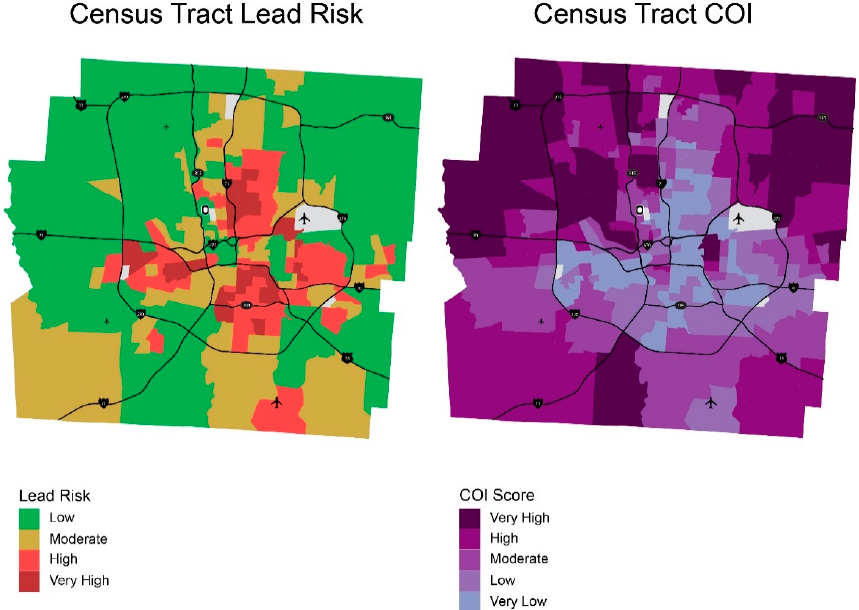
Figure 8. Lead risk versus Child Opportunity Index.